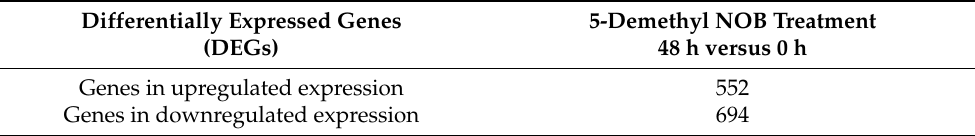
Table 1. The differentially expressed genes (DEGs) of 5-demethyl NOB-treated THP-1 cells.